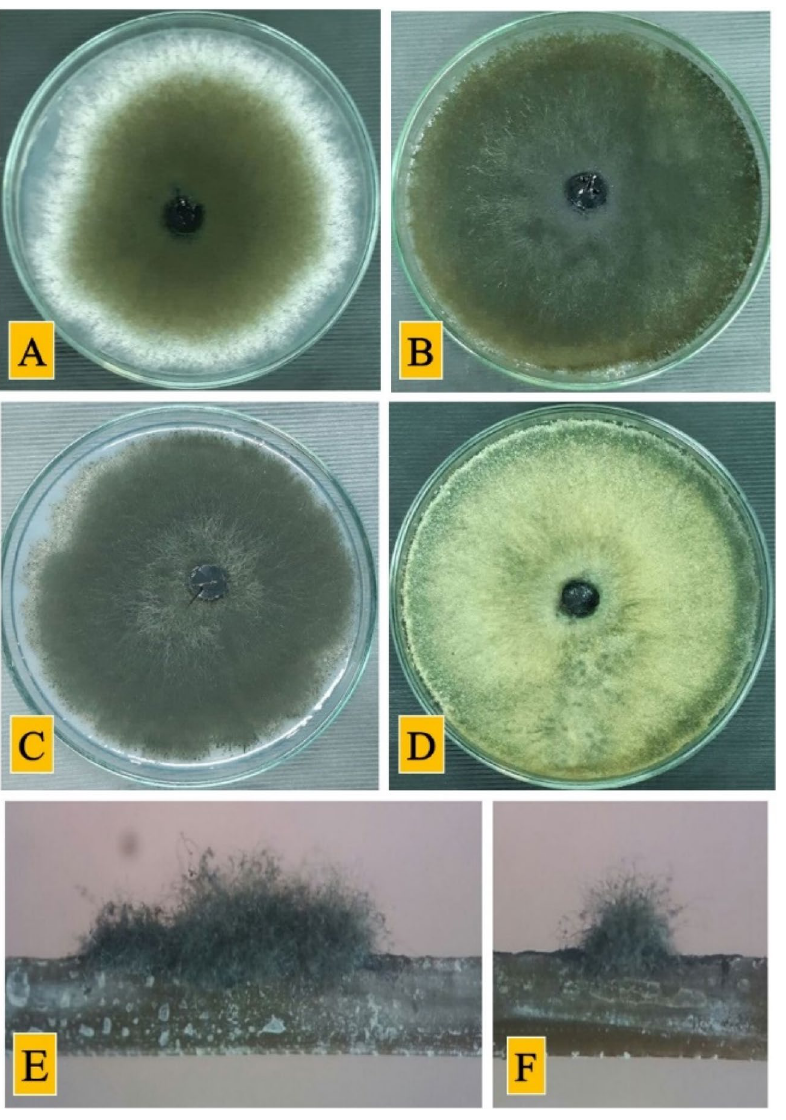
Figure 1. Fungi on potato dextrose agar (PDA) medium after 5 days ( A ); oatmeal agar (OA) medium after 8 days ( B ); potato carrot agar (PCA) medium after 8 days ( C ); malt extract agar (MEA) medium after 8 days ( D ); and conidiomata on pine needles in culture after 15 days ( E and F